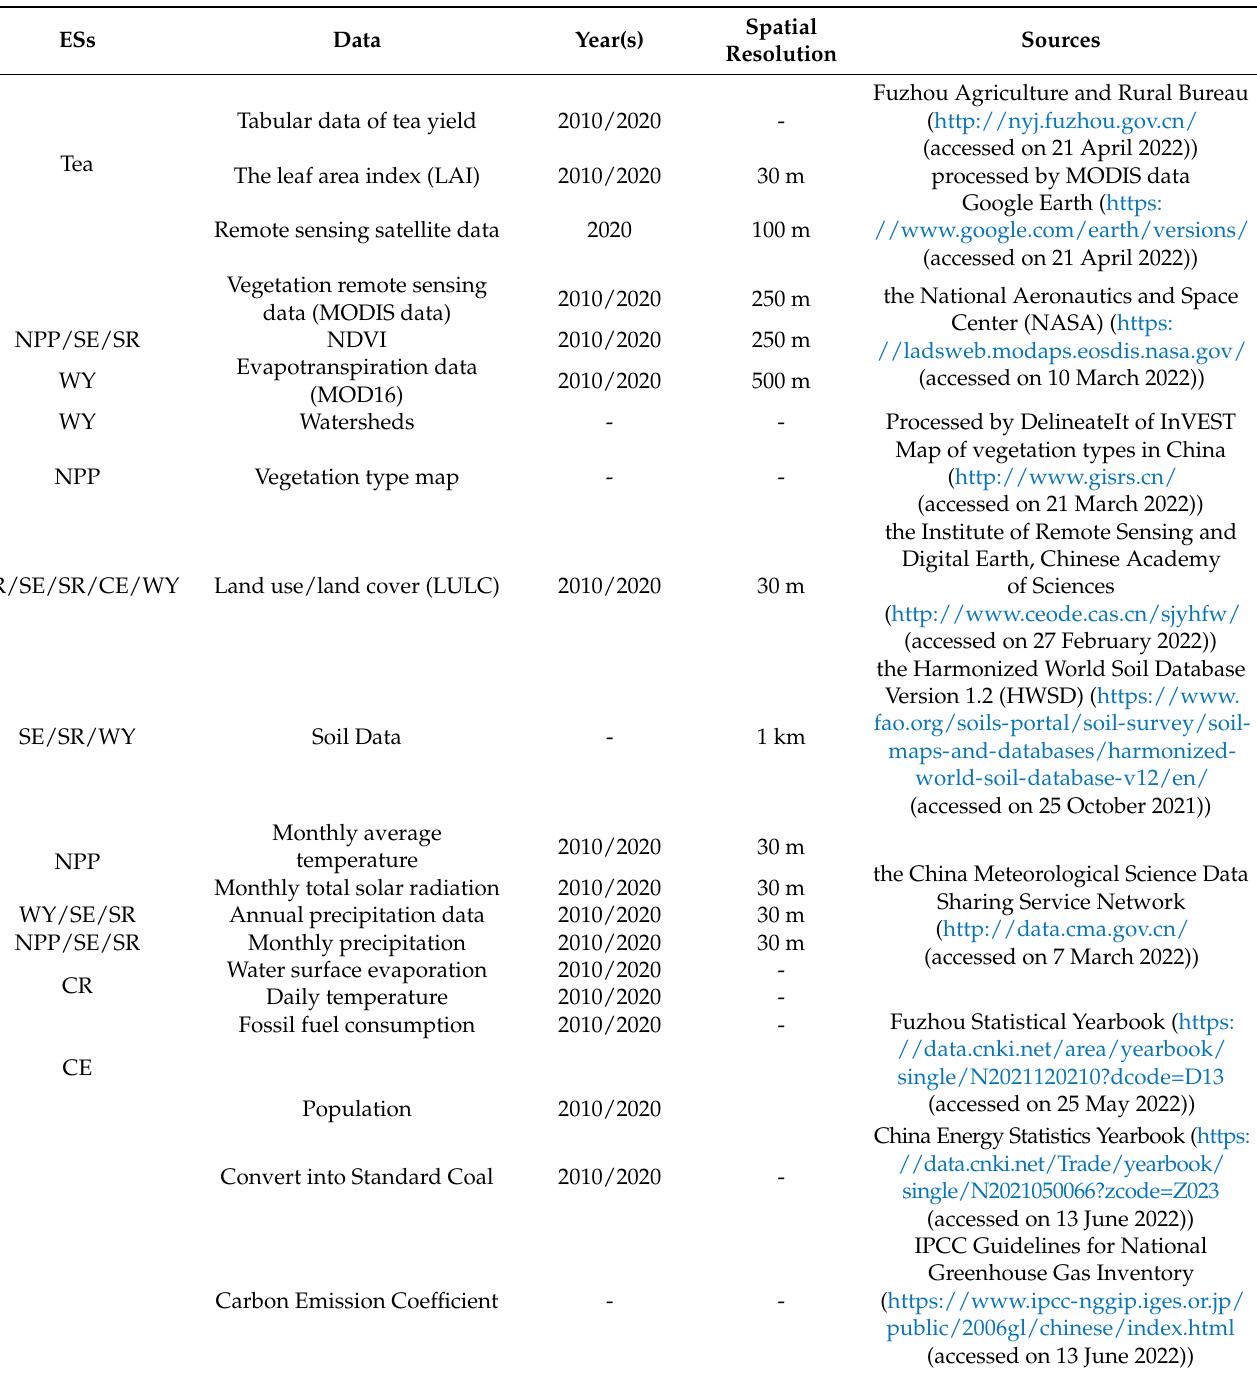
Table 1. The main data and data sources. Tea: tea production; WY: water yield; CR: climate regulation; SR: soil retention; SE: soil erosion; and CE: carbon